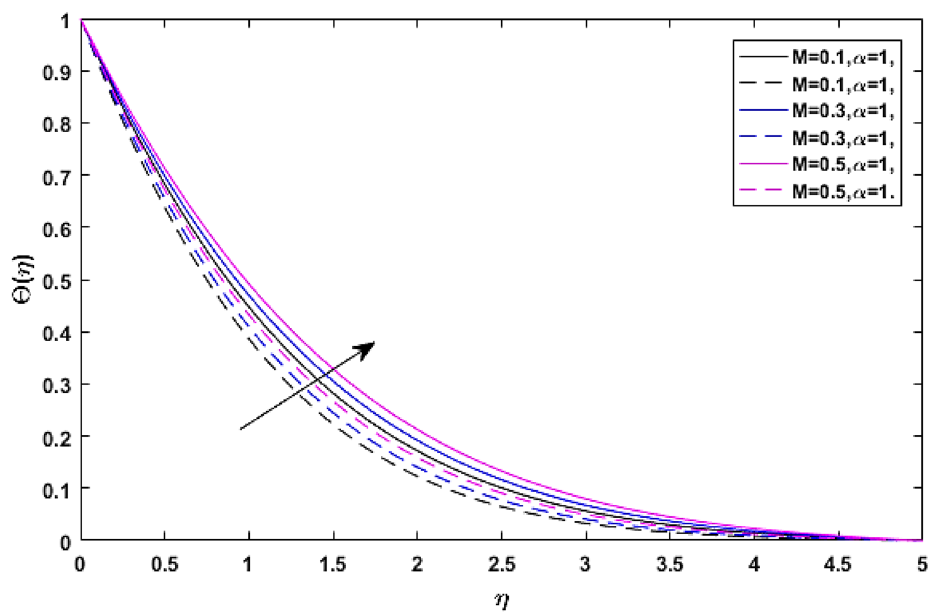
Figure 11. M versus temperature field when (cid:31) = E = Ec = 0.1, φ 1 = φ 2 = 0.02, Pr =